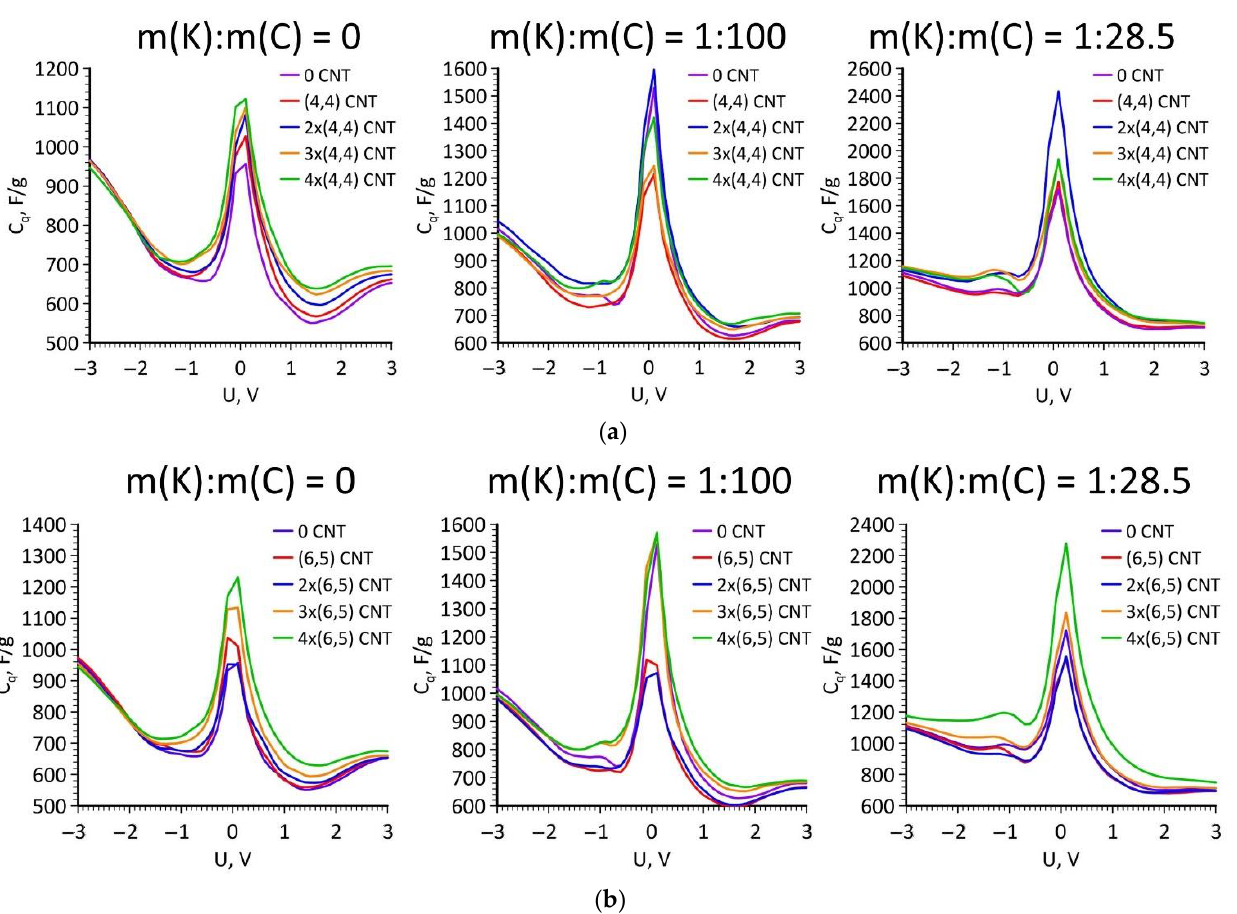
Figure 5. Quantum capacitance of GLC reinforced with (4,4) SWCNTs ( a ) at potassium content 0, 1:100, and 1:28.5, and with (6,5) SWCNTs ( b ) at potassium content 0, 1:100, and 1:28.5.